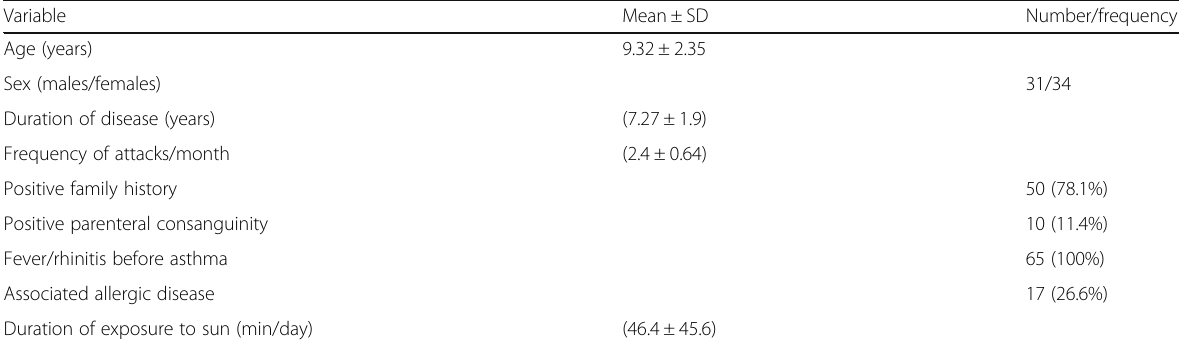
Table 1 Demographic and clinical data of the asthmatic patients ( n = 65) Variable